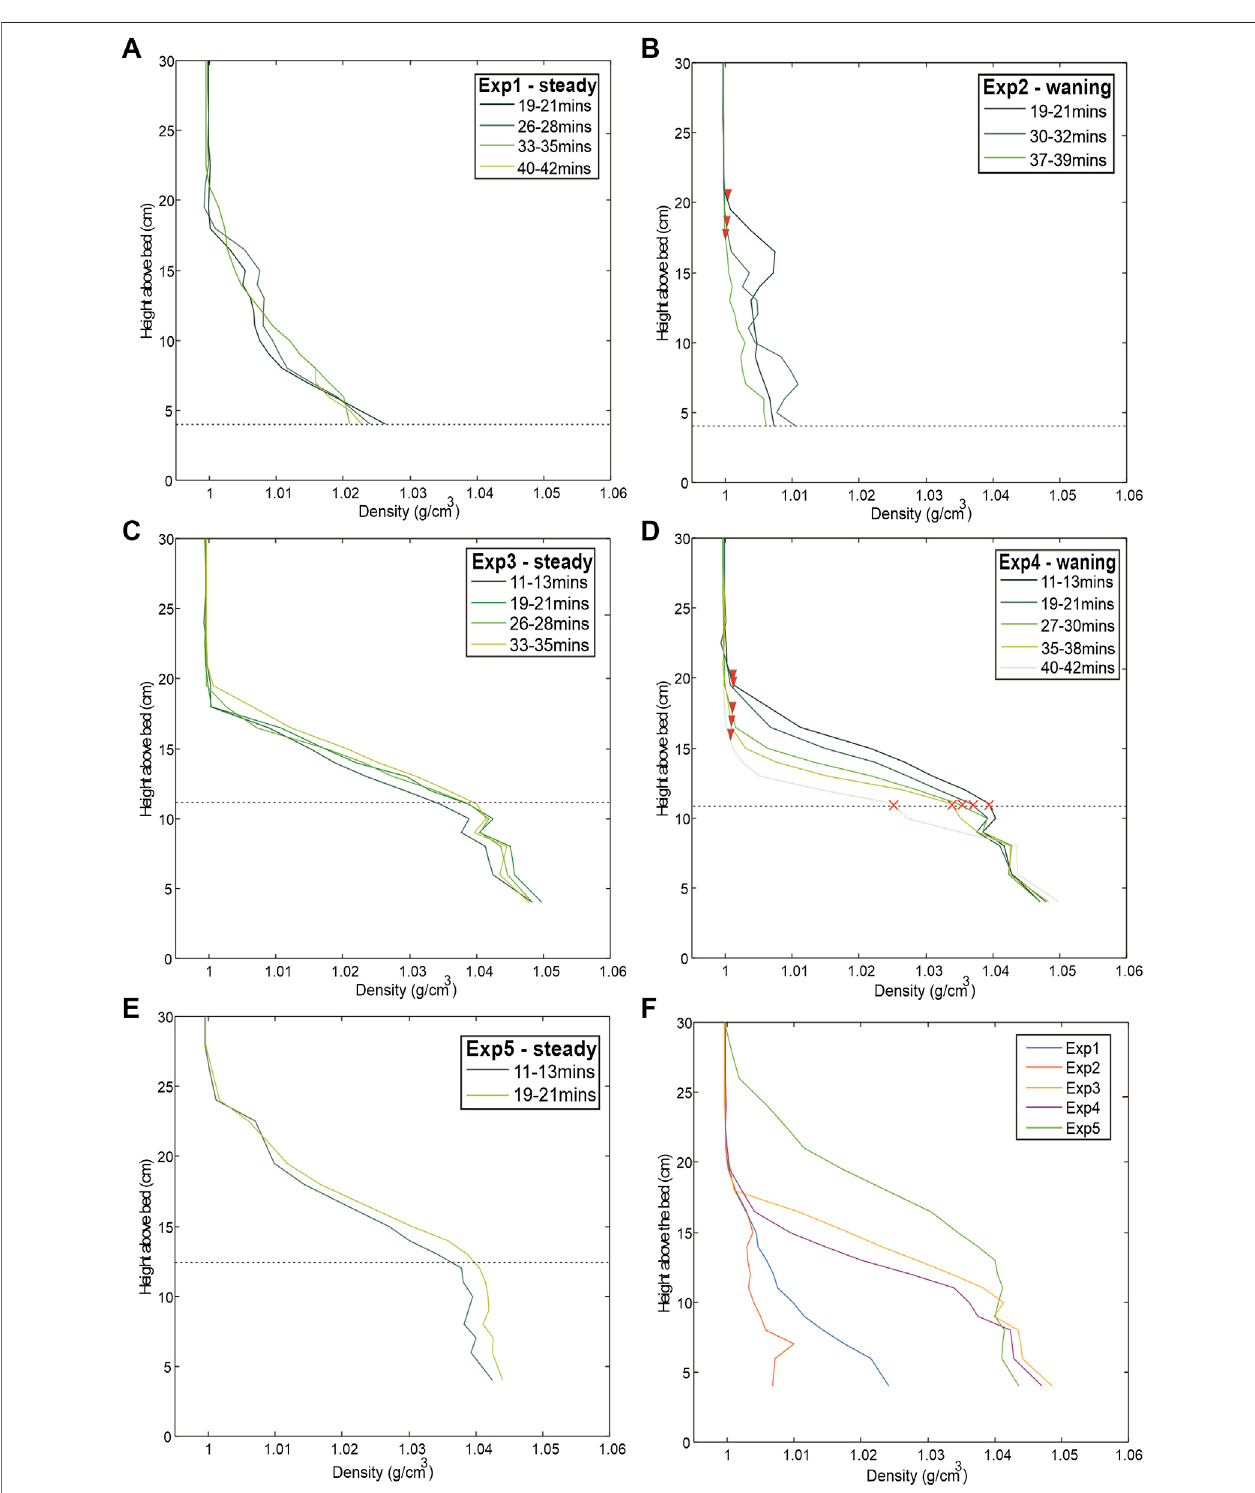
FIGURE4| Verticalconcentrationpro fi lesaveragedover2 – 3 min. Theblackdashed linedenotestheheightoftheinterfacebetweenupper and lowerdenserlayer andtheredcrossesattributethispointtospeci fi cpro fi les,depictingtheconstantheightoftheinterfacethroughouttherun.Experiments2and4arewaningcurrents,the red triangles mark the change in height of the upper surface of the current with the ambient fl uid over time. They depict the gradual reduction in height as the fl ow is slowed. Plot (F) shows average density pro fi les for each run based on available data in (A – E) . Experiments 1 – 5 correspond to plots (A – E) , respectively.